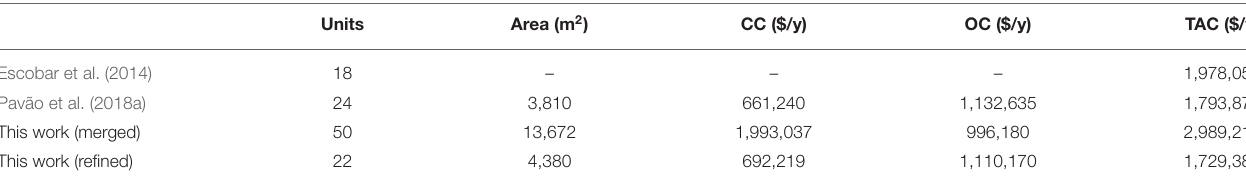
TABLE 3 | Comparison of the multiperiod HEN to the results reported in the